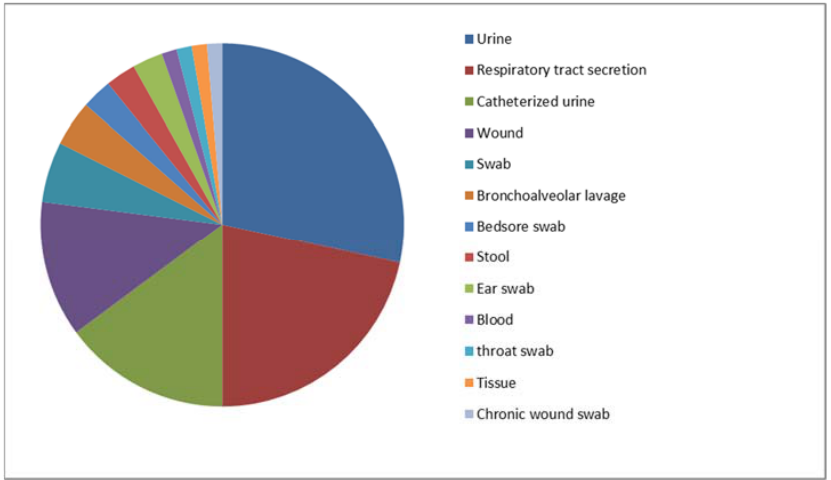
Figure 2. The origin (specimen types) of the multidrug ‐ sensitive P. aeruginosa strains included in the study ( n = 74).